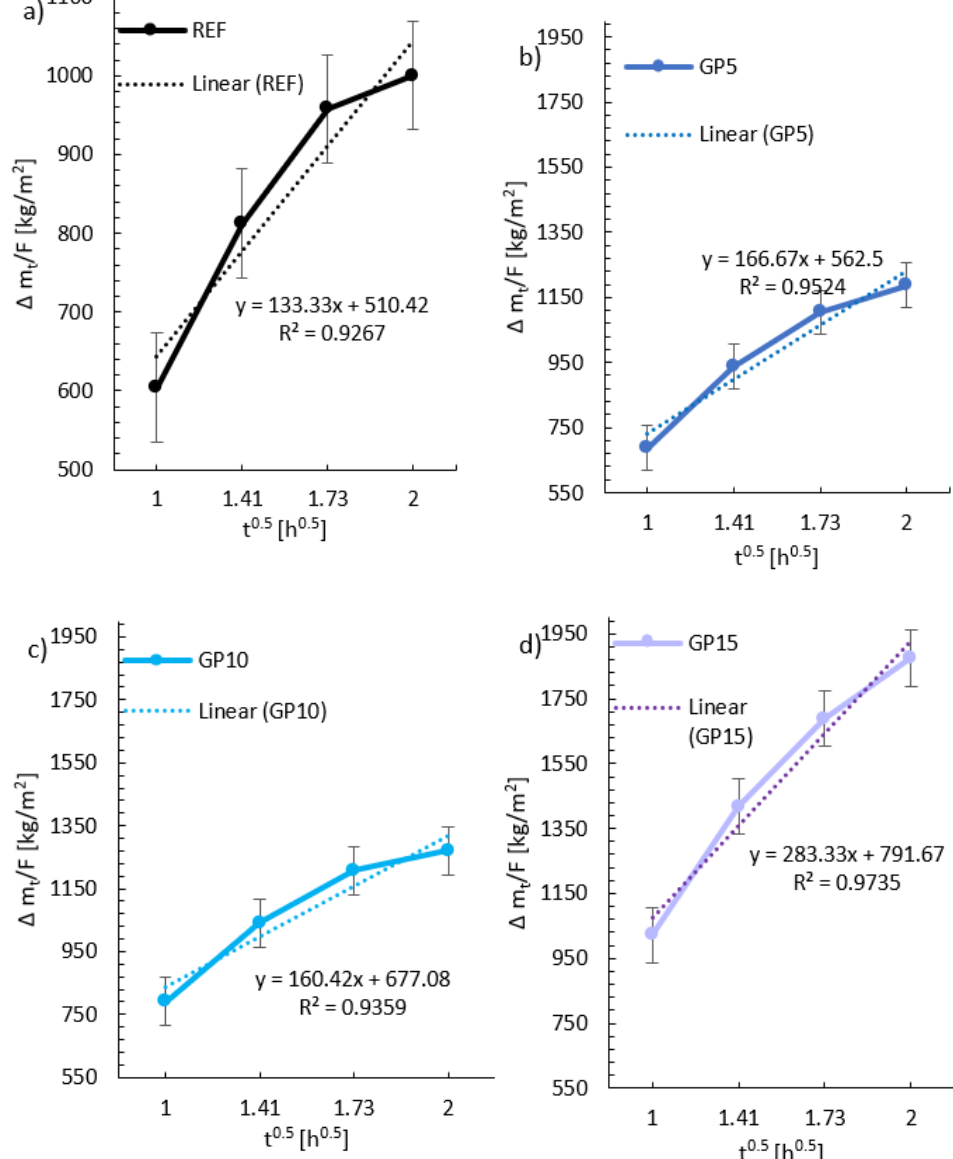
Figure 6. Graphs of capillary suction for the three measuring points with a linear trend line for: ( a ) the reference series; ( b ) the series with the 5% replacement of cement with granite powder; ( c ) the series with the 10% replacement of cement with granite powder; ( d ) the series with the 15% replacement of cement with granite powder. Based on the directional coefficients of the linear trend lines, Figure 7 was created in order to show the water sorption